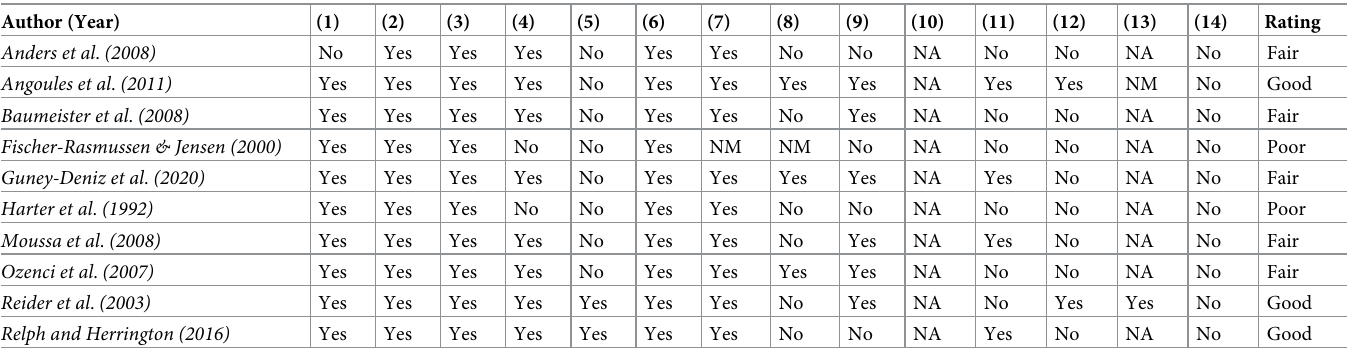
Table 3. Methodological quality of included